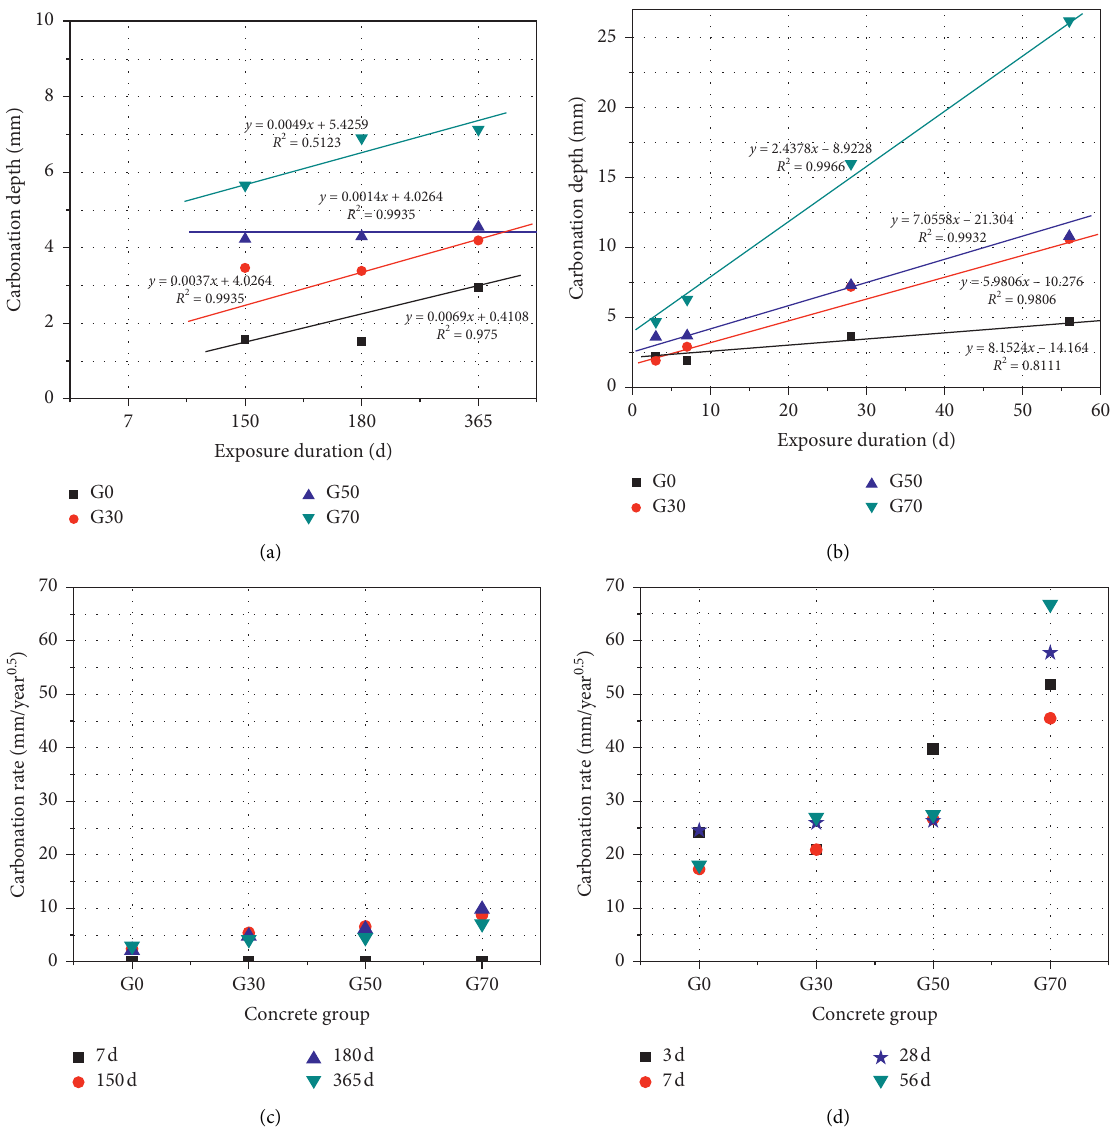
Figure 8: A typical plot of exposure duration vs carbonation depth fitting for (a) natural carbonation and (b) ACC and influence of exposure condition on rate of carbonation of concrete exposed to (c) natural carbonation and (d) accelerated